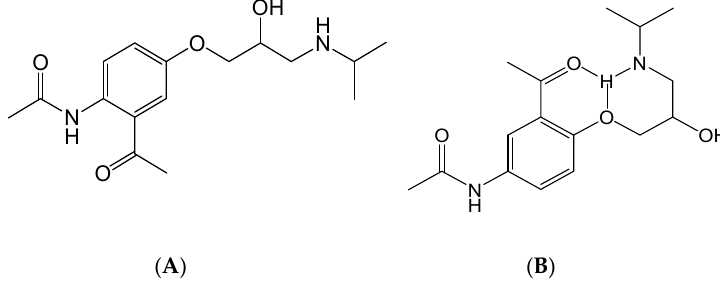
Figure 9. The possible chemical structure of diacetolol isomer detected in sample. ( A ) The first possible chemical structure. ( B ) The second possible chemical structure.